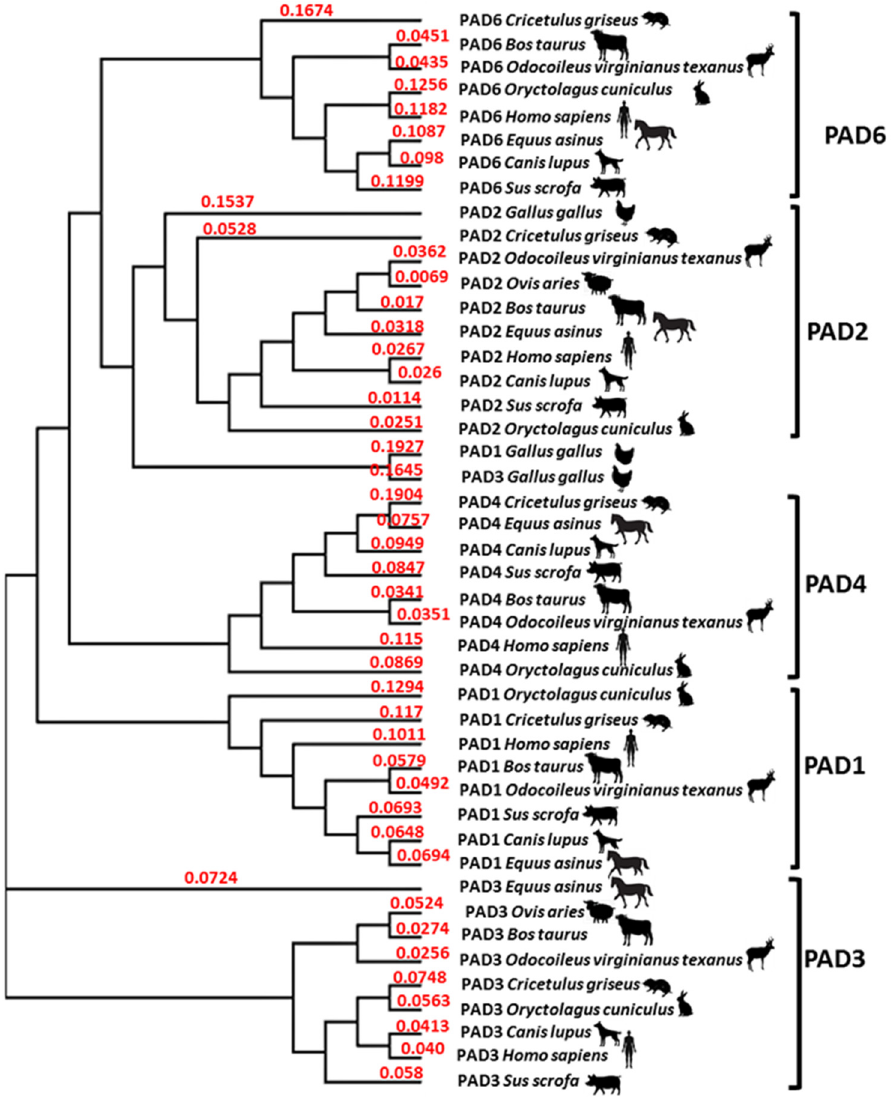
Figure 22. Neighbour joining tree for PAD isoforms. PAD isozymes from the species under study, or representative species if species-specific sequences were not available in NCBI, are included in the phylogeny tree in comparison with human PADs. The different PAD isoforms do group together in clades, except for the PADs from Aves, with all three known PAD isozymes (PAD1, 2, 3; using chicken, Gallus gallus , as a representative species), grouping closest with the PAD2 clade. The following protein sequences from NCBI were used: Human ( Homo sapiens NP_037490.2_PAD1, NP_031391.2_PAD2, NP_057317.2_PAD3, NP_036519.2_PAD4, AAR38850.1_PAD6); Chicken (as a